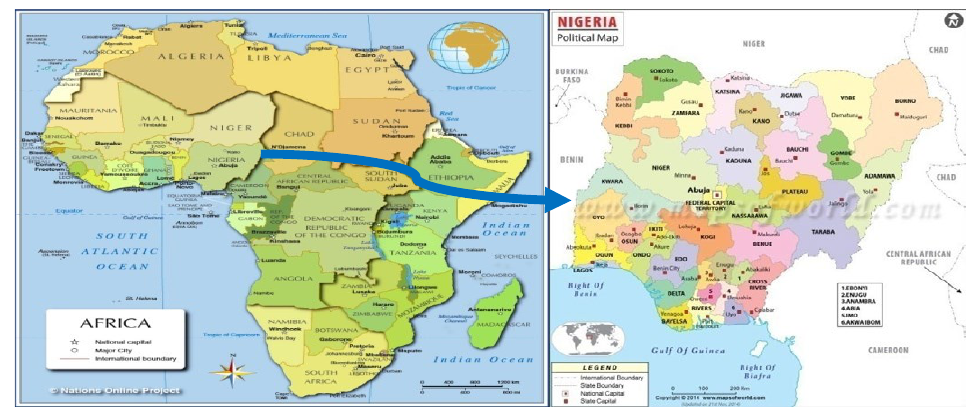
Fig. 1: Geographic location of the study area in Nigeria showing all 36 States and FCT